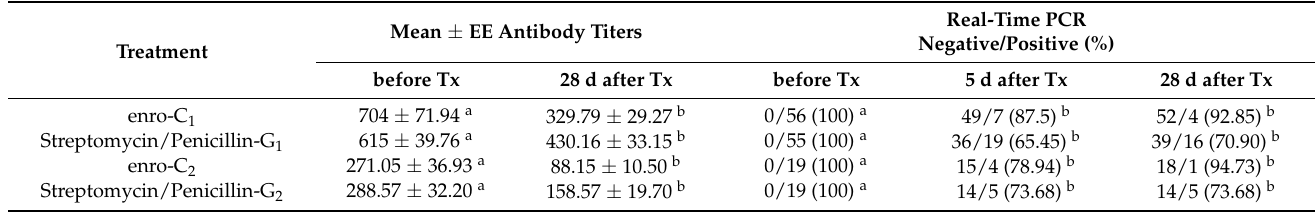
Table 3. Antibody titers from the microscopic agglutination test (MAT) and polymerase chain reaction (PCR) from urine samples in cows affected by Leptospira spp. and treated either with enrofloxacin hydrochloride-dihydrate (enro-C) or streptomycin plus procaine penicillin-G, in two geographical settings: the highlands (1) and the tropics in Mexico (2).